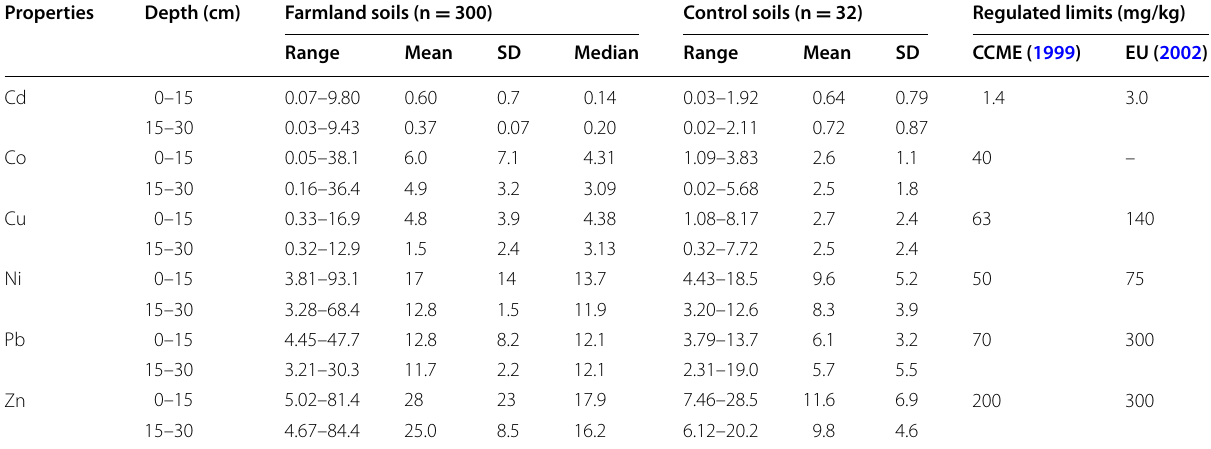
Table 2 Total soil heavy metals content of farmland Properties